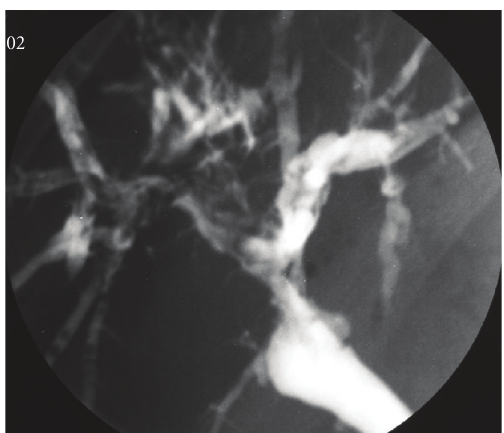
Figure 1: Intrahepatic presentation of ischemic-type biliary lesion six months after hepatic transplantation for chronic hepatitis B- associated liver cirrhosis. The patient’s hepatic artery is patent, and there is no other known cause for the destruction of the intrahepatic biliary